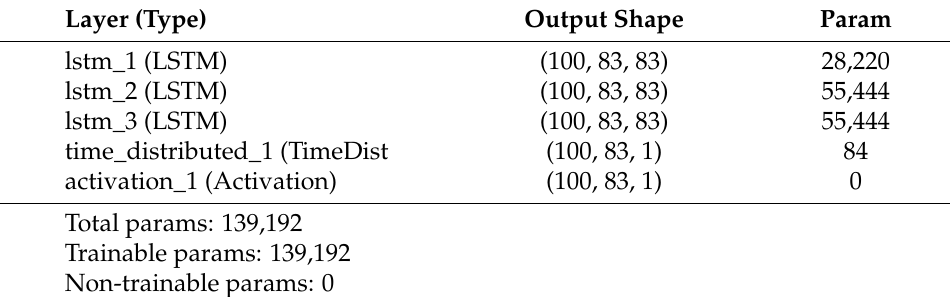
Table 3. Summary of model